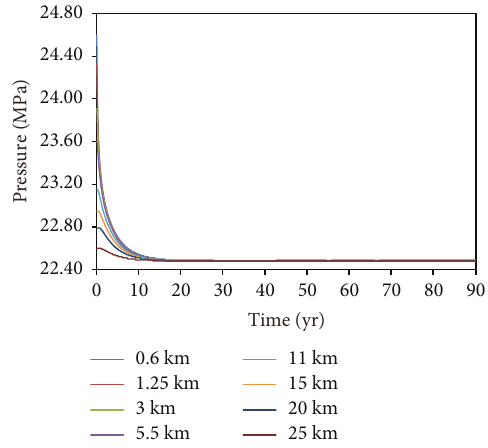
Figure 27: Pressure changes at the pressure monitoring points in models with di ff erent numbers of wells in the 10th year.